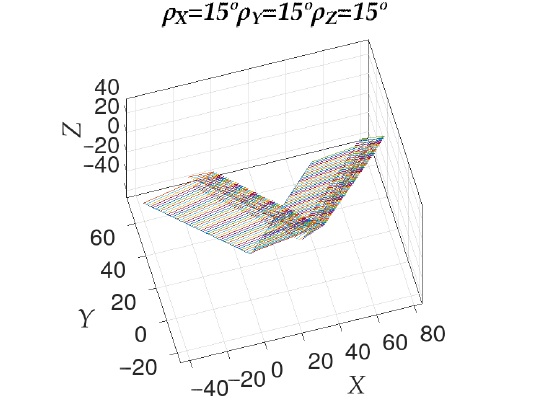
Figure 4. Orientation of the axes of rotation between the normals of the ideal and calculated planes, superimposed with the value of (cid:101) that gave rise to that axis of